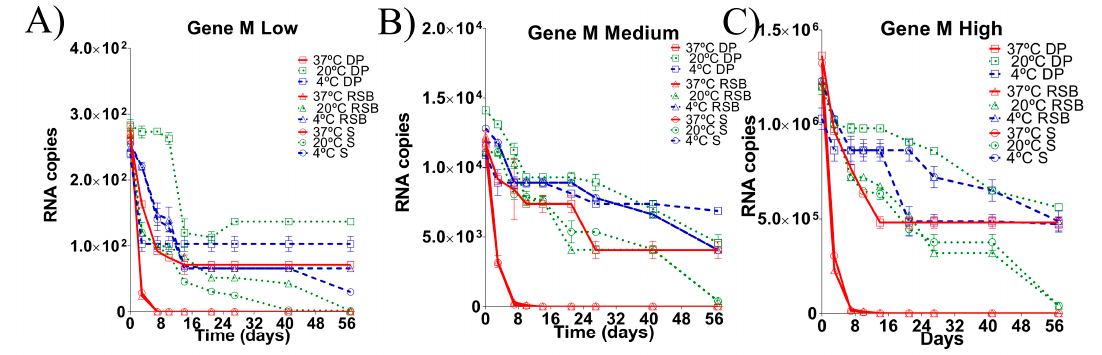
Figure 1. Comparison of RNA load values detected from M gene diagnostic target region under different storage conditions for 57 days post incubation (dpi). Dynamics of degradation at ( A ) low RNA load, ( B ) medium RNA load and ( C ) high RNA load. Each matrix of storage is denoted (S: swab matrix, RSB: RNA safe buffer described by Hoffmann et al. (2006) modified in this study, DP: dry pellet matrix), each temperature of storage is also denoted. Data is mean of qRT-PCR from triplicate samples. Based on the limit of detection of the assay, samples with ct > 35 were considered negative (see Supplementary Material Figure S1A).